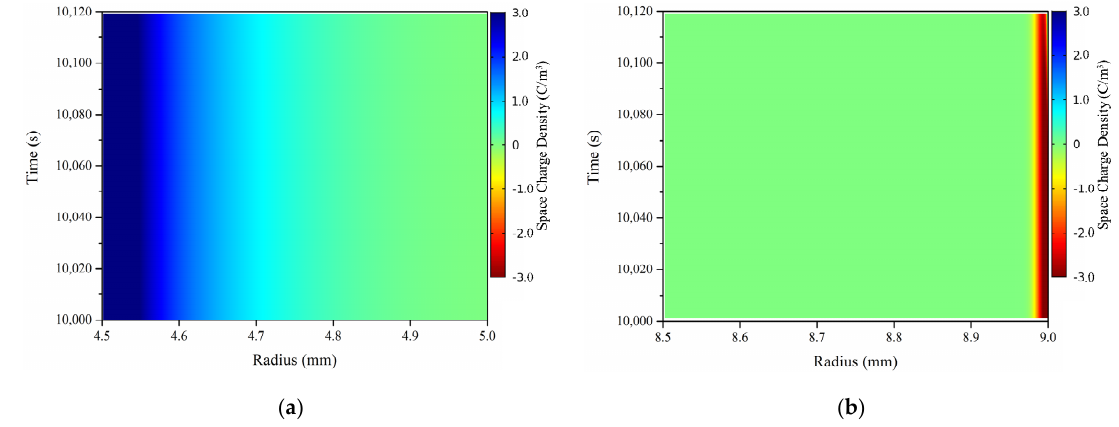
Figure 7. Space charge distribution at 250 A: ( a ) Conductor side charge density (C / m 3 ); ( b ) sheath side charge density (C / m 3 ).